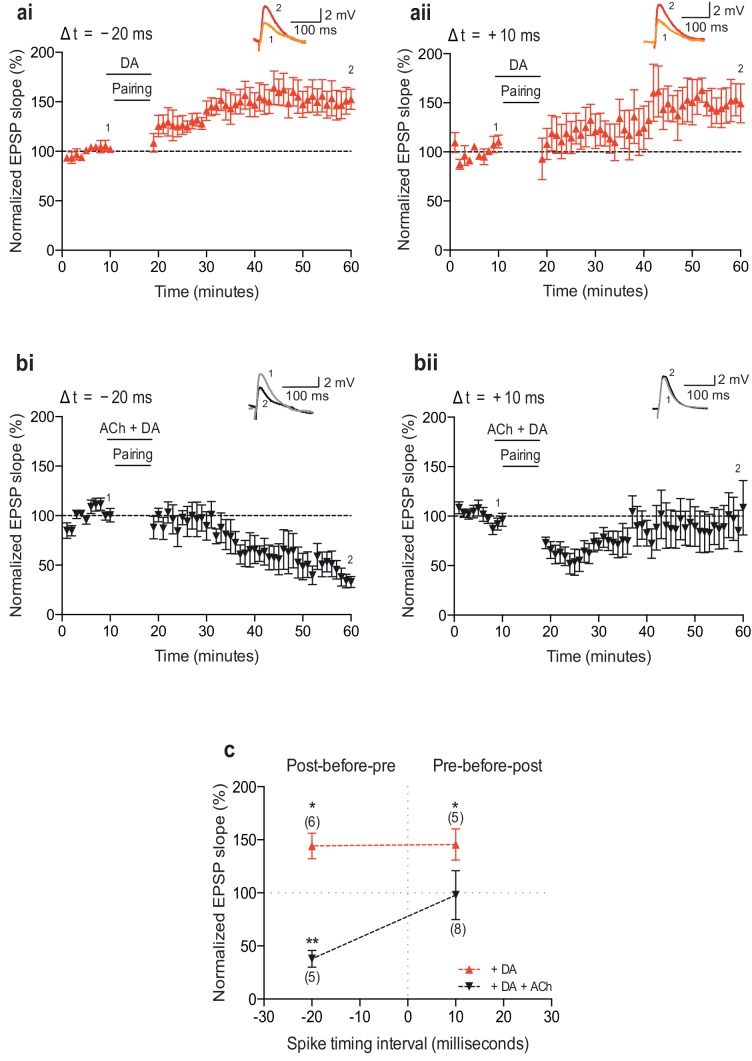
Neuromodulation of STDP by dopamine and co-application of dopamine and acetylcholine.(a) Dopamine (DA) biases STDP toward potentiation: (ai) post-before-pre pairing protocol with Δt = −20 ms (data from Figure 1e in Brzosko et al., 2015) and (aii) pre-before-post pairing protocol with Δt =+10 ms. Traces show an EPSP before (1) and 40 min after pairing (2). (b) Co-application of DA and acetylcholine (ACh) yields depression: (bi) post-before-pre pairing protocol with Δt = −20 ms and (bii) pre-before-post pairing protocol with Δt =+10 ms produces initial synaptic depression which reverts back to baseline. Traces are presented as in a. (c) Summary of results. Each data point is the mean percentage change from baseline of the EPSP slope. Error bars represent s.e.m. Significant difference (*p<0.05, **p<0.01) compared with the baseline (two-tailed Student’s t-test). The total numbers of individual cells are shown in parentheses.